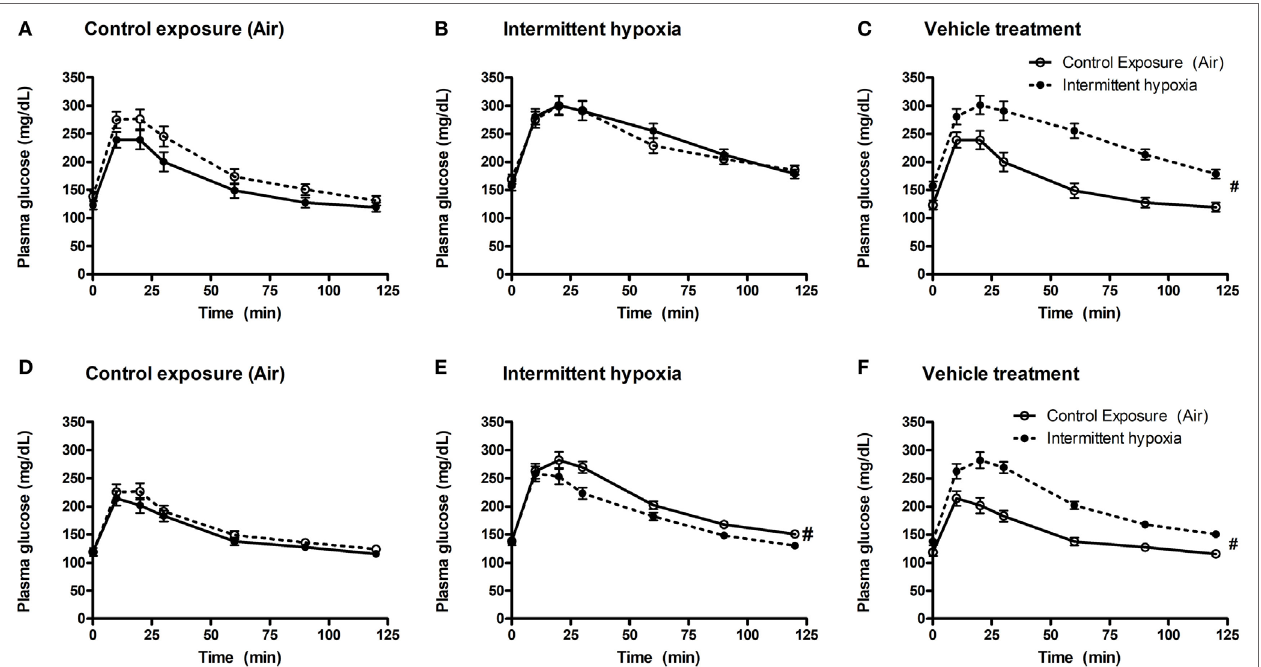
FigUre 1 | Intraperitoneal glucose tolerance tests (GTTs) in BQ-123 (a,B) , BQ-788 (D,e) and vehicle (c,F) treated groups. Data were analyzed using repeated measures ANOVA analysis of the GTT profiles investigating interaction between exposure groups (drug-treated versus vehicle-treated) and time of GTT. Upper panels: BQ-123 and saline treated groups. Lower panels: BQ-788 and propylethylene glycol (vehicle). # indicates p < 0.05 for differences between drug-treated and vehicle-treated groups. N = 10 for each group. FigUre 2 | Area under glucose curve (AUC) during intraperitoneal glucose tolerance test. Interaction between hypoxic exposure and drug treatment was investigated using two-way ANOVA. * indicates p < 0.05 for differences between a control group (intermittent air) and a group exposed to intermittent hypoxia (IH). N = 10 for each group.